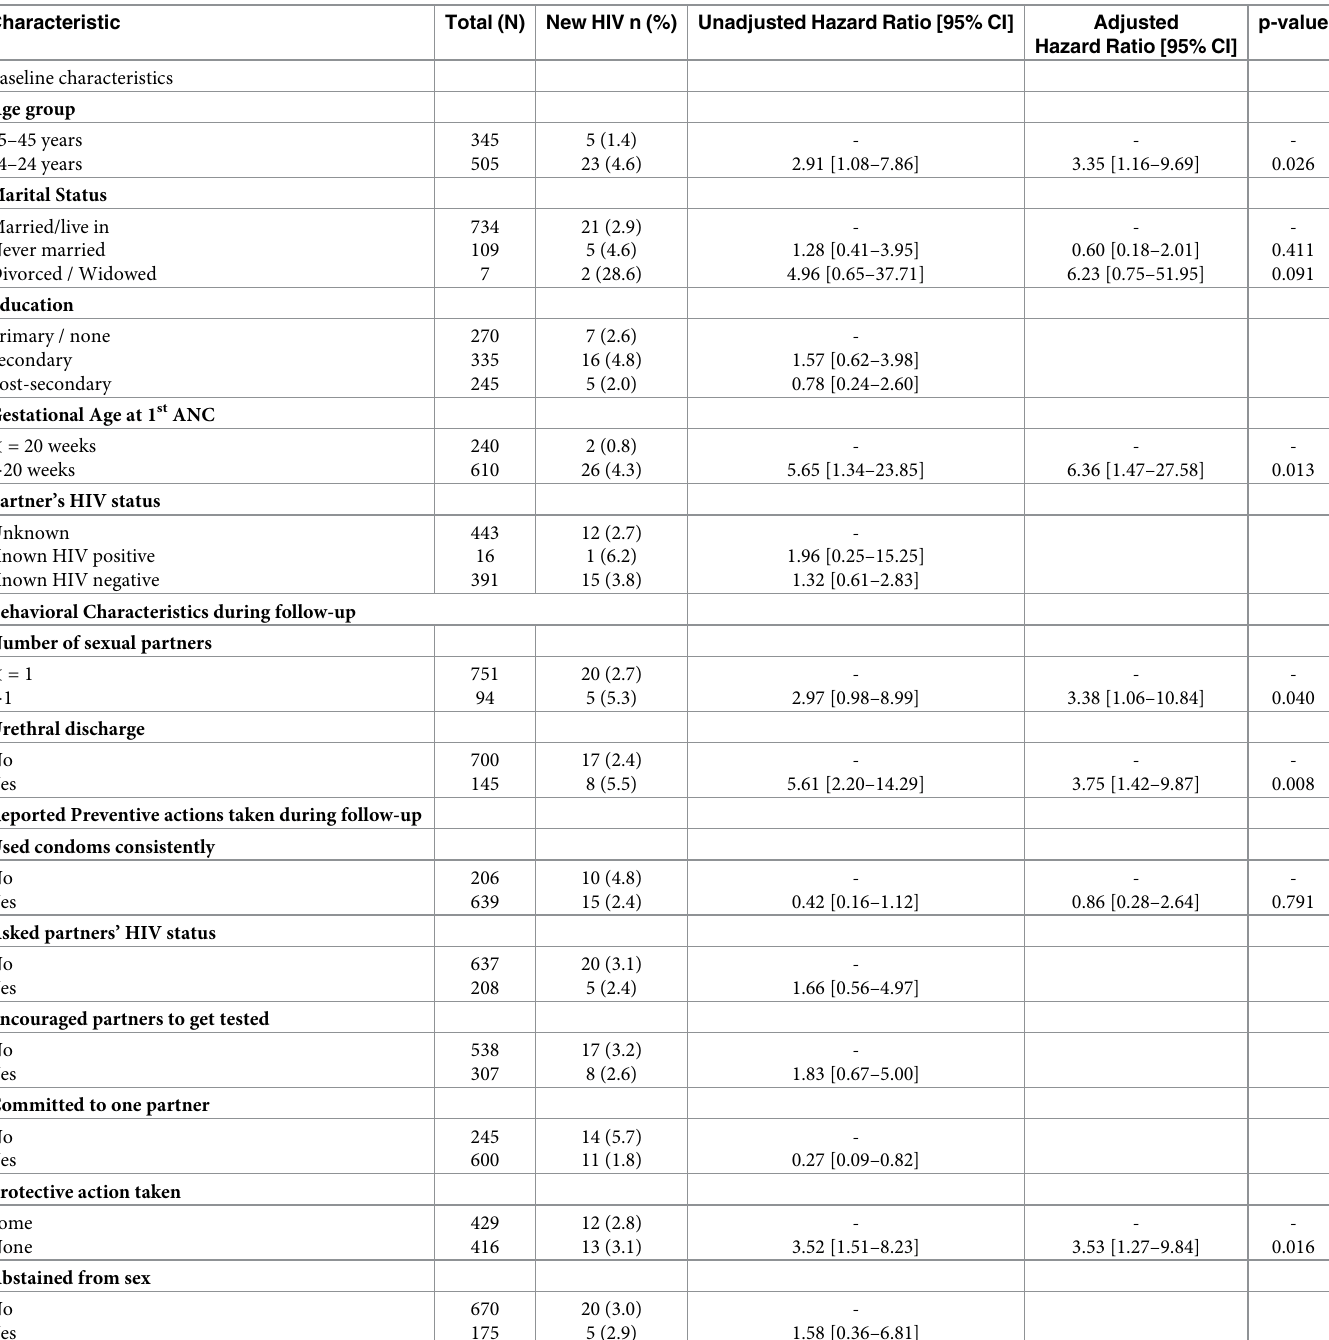
Table 3. Number of HIV seroconversion by selected baseline characteristics and reported risk factors during follow-up among women attending ANC in Lesotho.